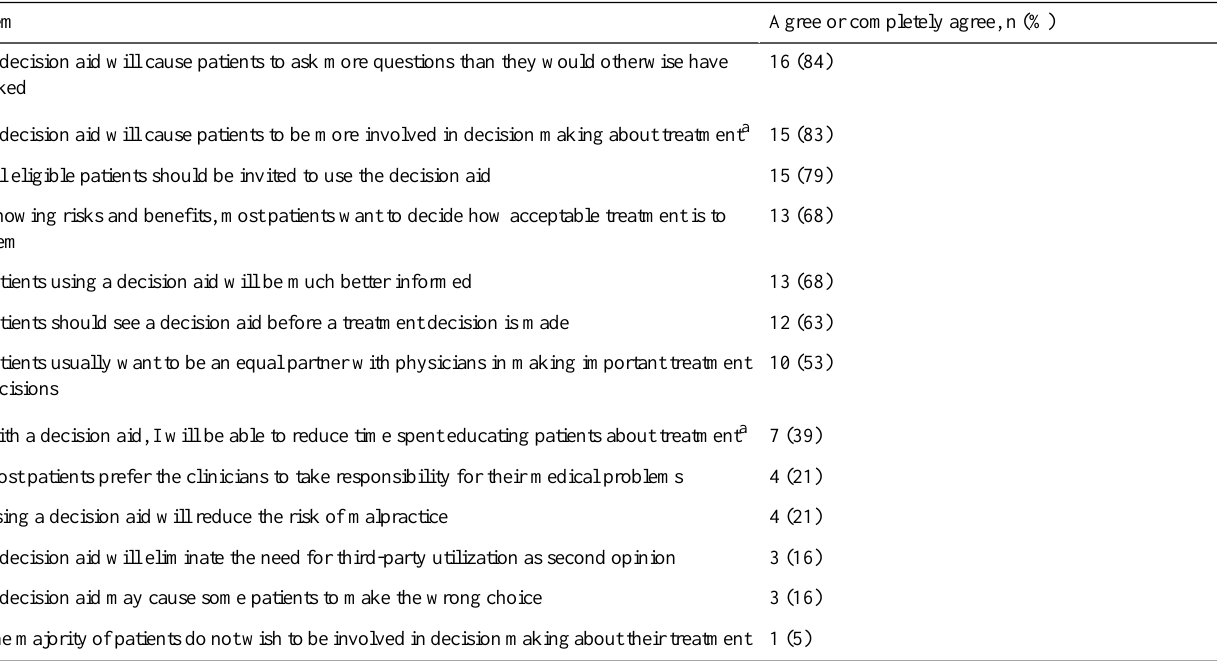
Table 1. Percentage of clinicians (completely) agreeing with statements about shared decision making and decision aids (n=19).